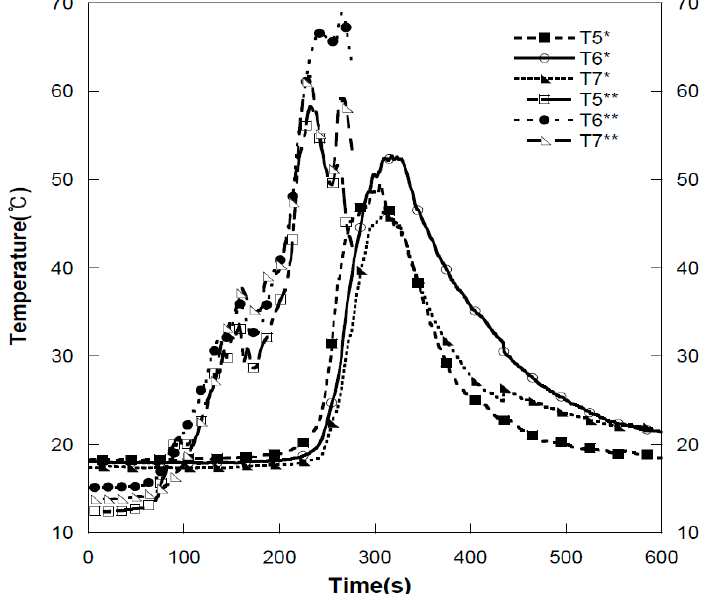
Figure 13. Comparison of the average heat air current temperatures around the stream of breath in fire tests of the fuel package for multiplexes, according to discharge pressure (*: 1 bar (0.1 MPa); **: 0.7 bar (0.07 MPa)). Table 4. Maximum temperatures by thermocouple position in the fire tests at a discharge pressure of 0.7 bars (0.07 MPa).